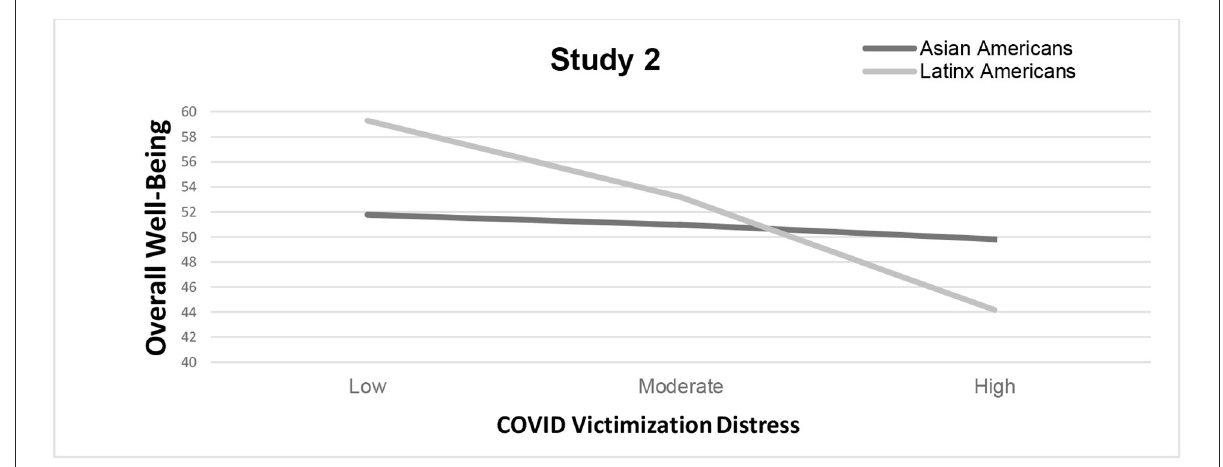
FIGURE5 Changes in overall well-being as a function of race and everyday racism for study 2 (September 2021–April 2022). Note . Results suggest race as a significant moderator ( p < 0.05) for the relationship between COVID-19 victimization distress and overall well-being. Latinx Americans experienced lower overall well-being as a function of COVID-19 victimization distress compared to Asian